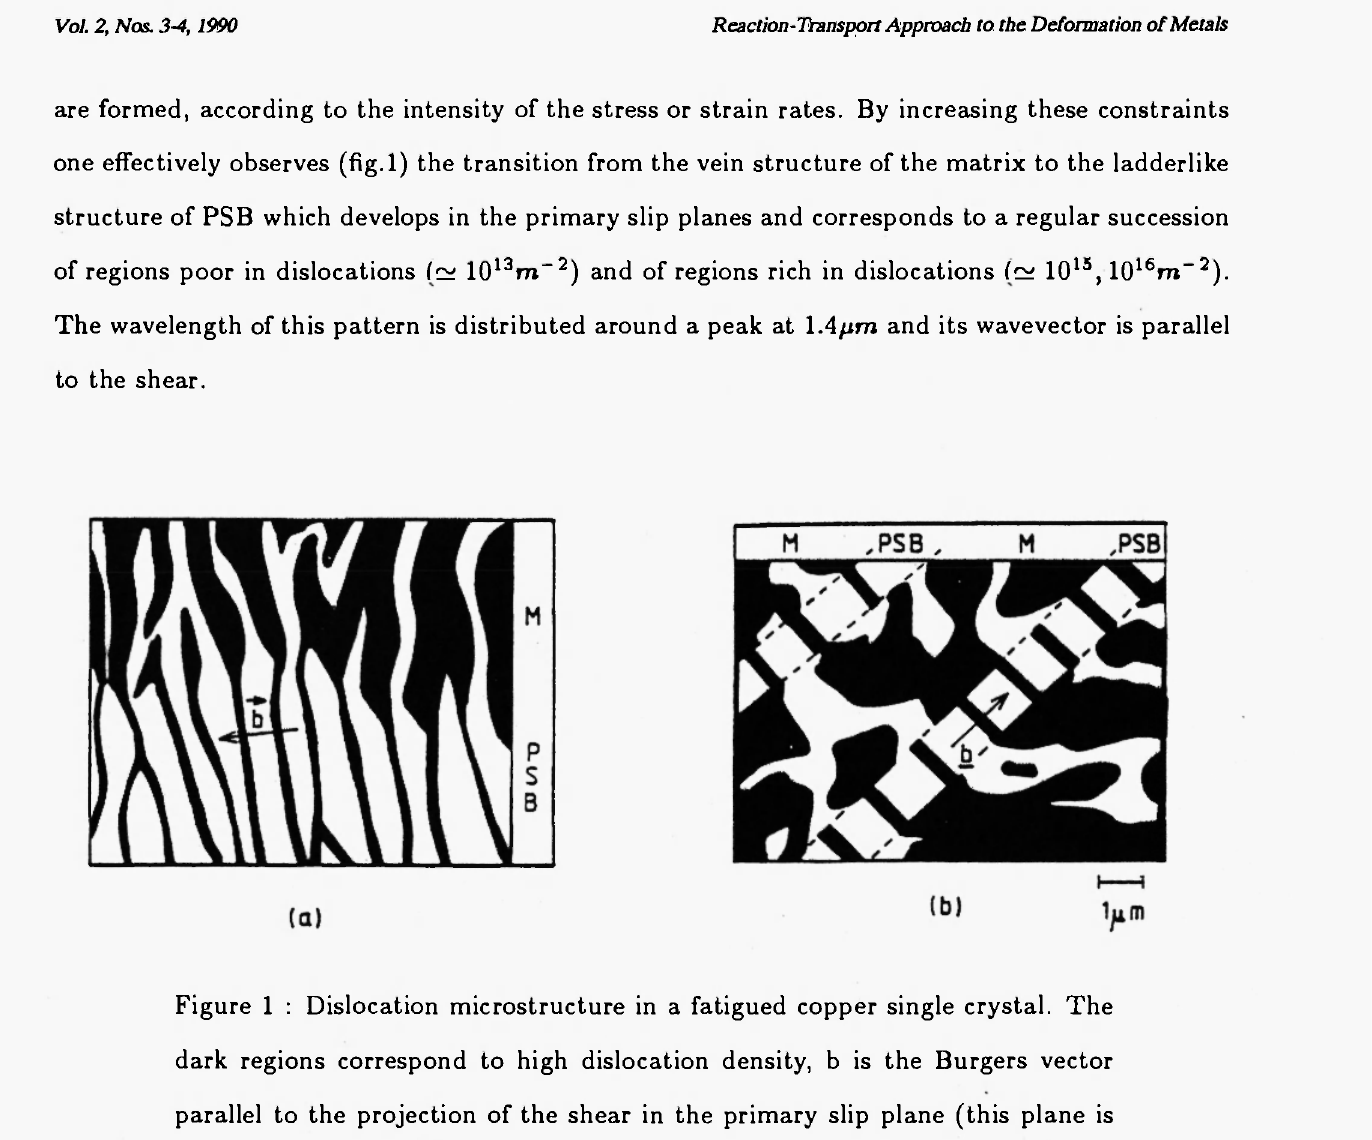
Figure 1 : Dislocation microstructure in a fatigued copper single crystal. The dark regions correspond to high dislocation density, b is the Burgers vector parallel to the projection of the shear in the primary slip plane (this plane is represented in (a) while the cross-slip plane represented in